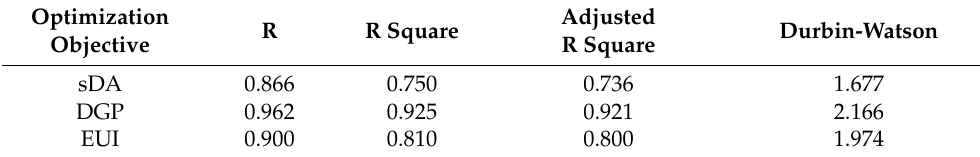
Table 11. Fabric shading SAS design parameters linear regression model.